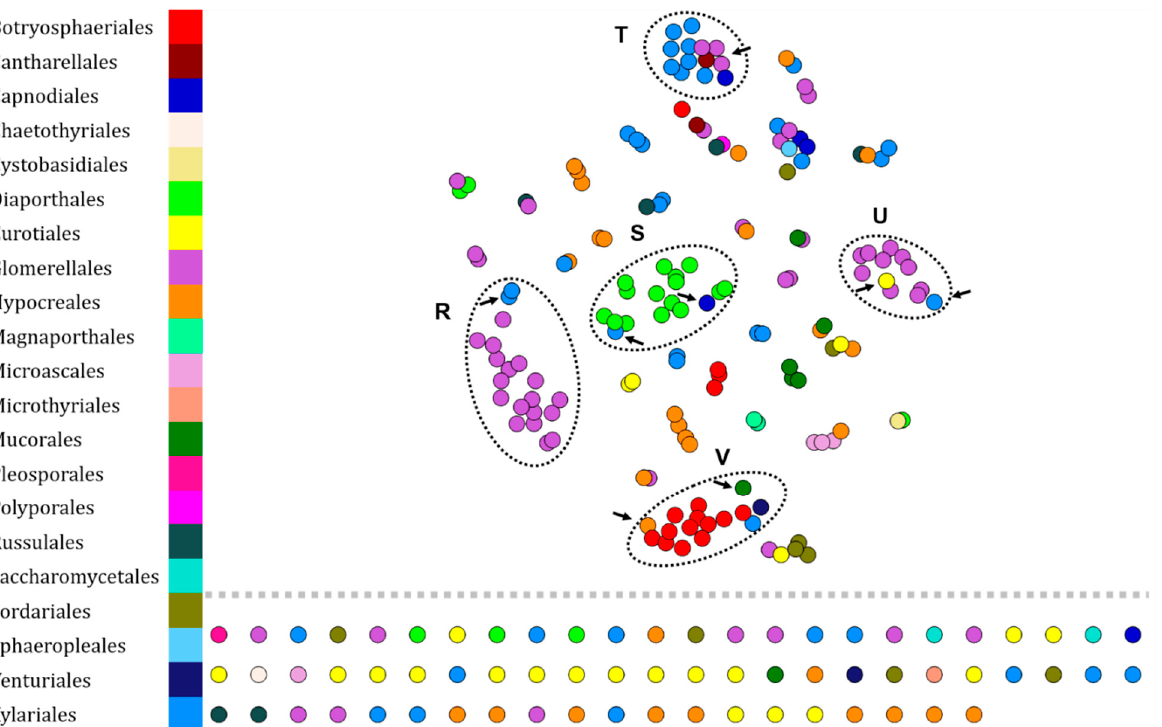
Figure 5. Visualization of 230 protein fingerprints of environmental fungi (230 isolates—BNSB’s database) set by t-SNE. Each node represents the protein fingerprint of an isolate and is colored according to the taxonomic order of the organism. Arrows indicate illogical attributions within clusters (annotated from R to V).